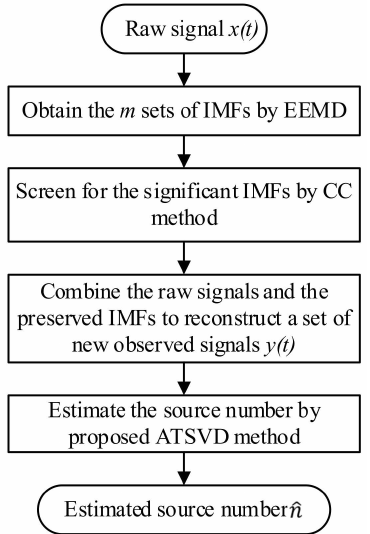
Figure 1. The procedure of source number